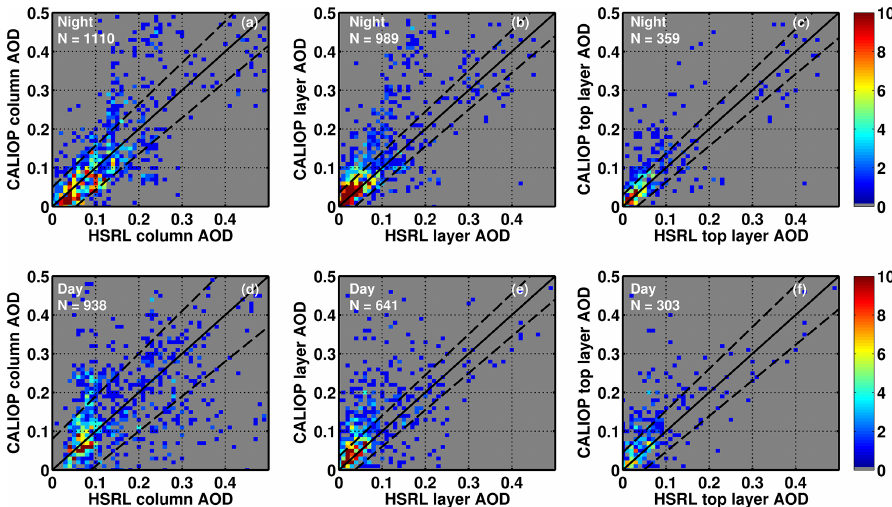
Figure 5. Scatterplots of column AOD (a, d) , individual layer AOD (b, e) , and top layer only AOD (c, f) . The top row shows night lighting conditions and the bottom row shows daytime lighting. The color bar indicates the number of points in each grid cell. The one-to-one line is in solid black on all figures and the dashed lines represent the error estimates reported in Table